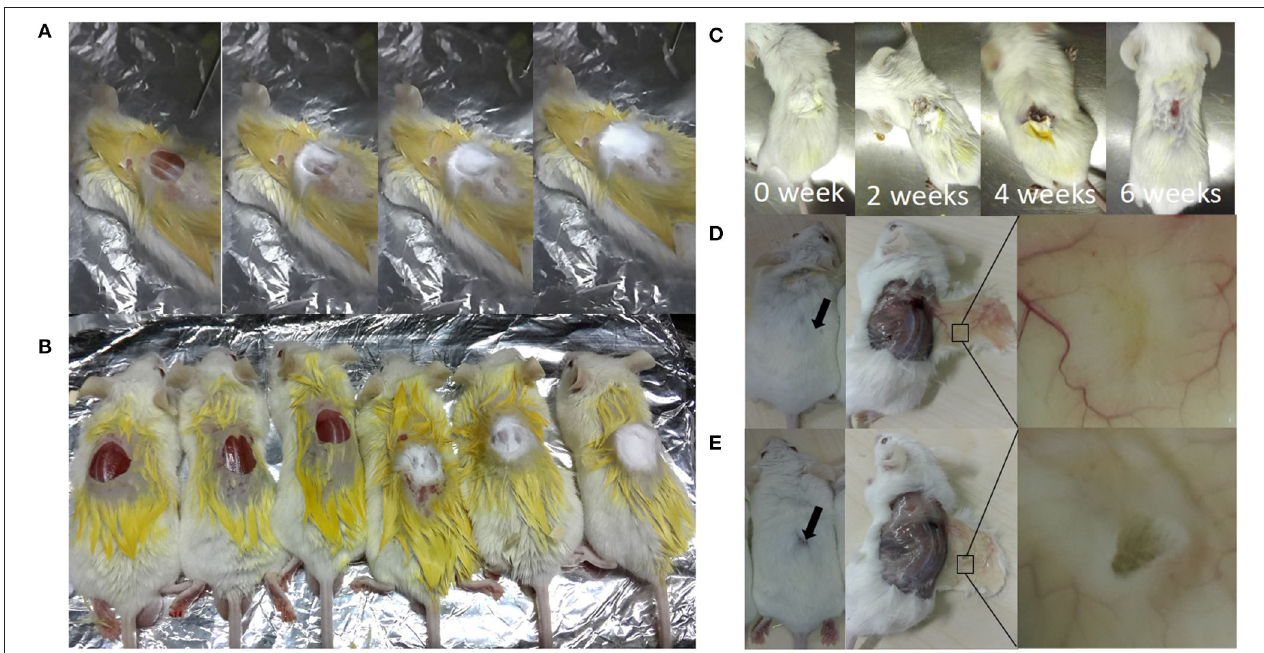
FIGURE 8 | In-situ repair of skin defects in Balb/c mouse. (A) A process of in-situ repair of skin defects; electrospinning was performed after wound creation immediately; (B) Balb/c mouse after repairing (right, three mice) or not (the NC group; left, three mice); (C) dynamic observation of wound healing; (D) 8 weeks after electrospinning in-situ repair, showing skin defects were completely repaired; (E) control group, showing incomplete repair after surgery for 8 weeks.